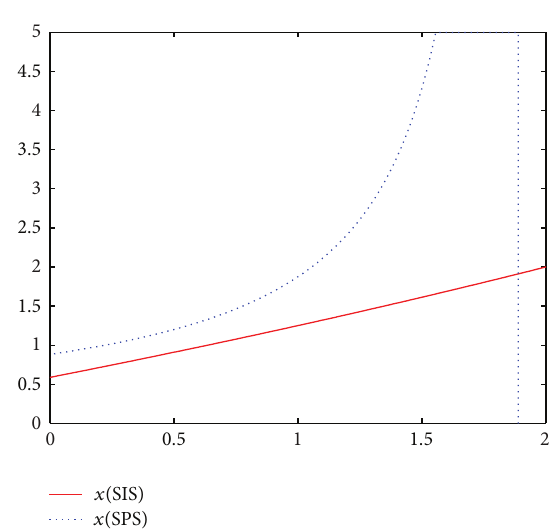
Figure 2: Equilibrium R&D